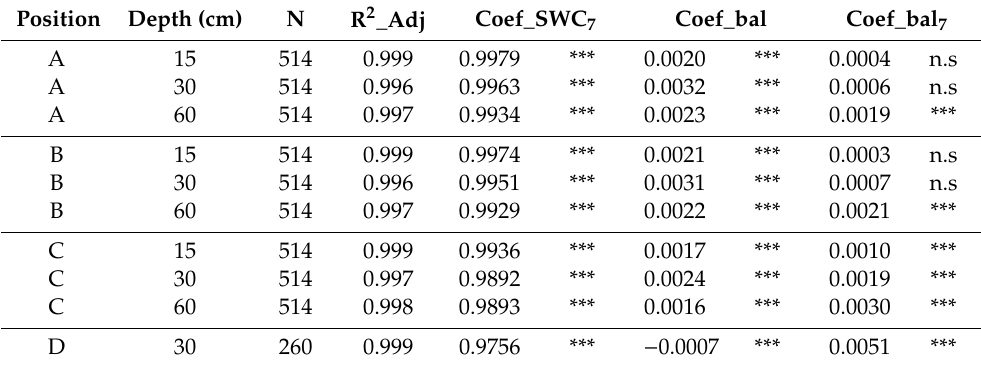
Figure 14. Sample of di ff erent types of sensor responses to the soil water balance, corresponding to di ff erent sensor locations in Plot II in June 2018. Table 4. Summary of dependence of soil water content (SWC) simulated by HYDRUS-3D on the simulations of a week before (Coef_SWC 7 ), the water input / output balance of the day (Coef_bal) and on the water input / output balance of the whole previous week (Coef_bal 7 ). N corresponds to the number of SWC measurements.